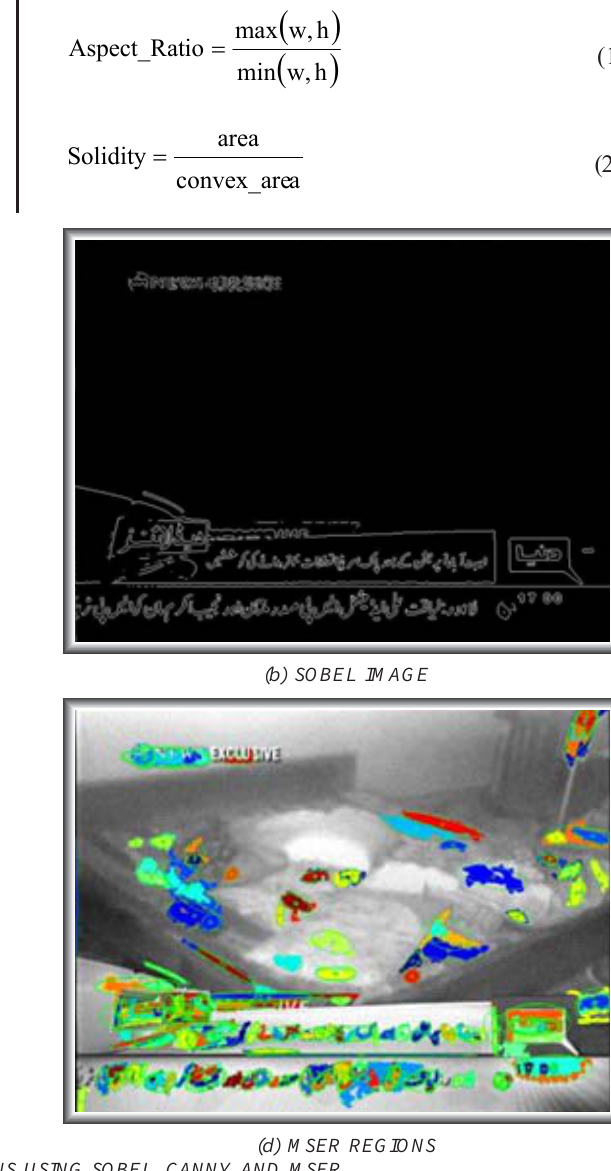
FIG. 3. DETECTED TEXT REGIONS USING SOBEL, CANNY, AND